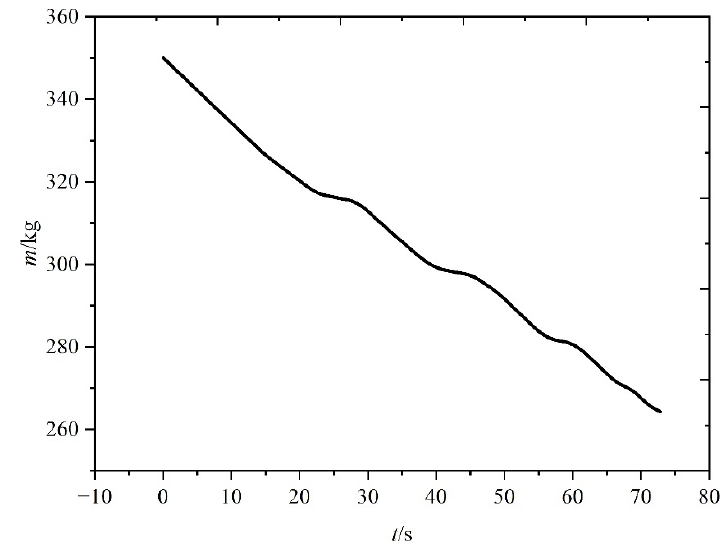
Figure 18. Vehicle mass under case 2 in the third scenario vs. time.